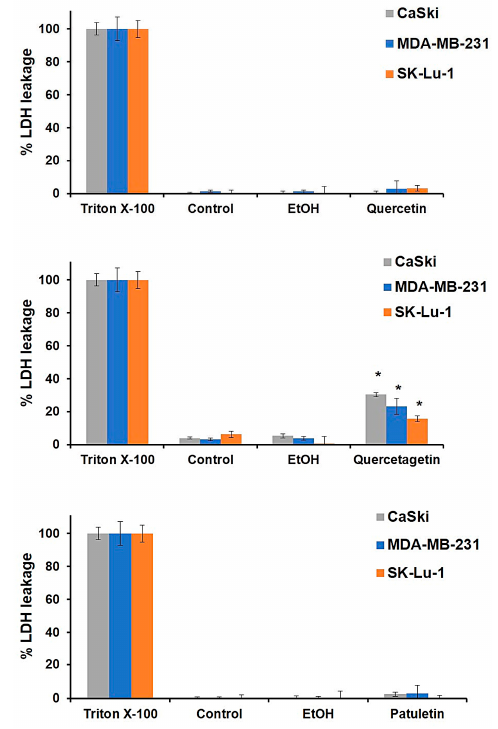
Figure 5. LDH activity induced by quercetin, quercetagetin and patuletin on CaSki, MDA-MB-231 and SK-Lu-1 cultures. In each case, 7500 cells/well were seeded in 96-well tissue culture plates. After 24 h, the medium was removed, and the cells were stimulated with the IC 50 values for quercetin, quercetagetin and patuletin, or EtOH (10 µ L/mL). The amount of lactate dehydrogenase (LDH) released into the culture supernatant was measured after 24 h of treatment. Experimental data are presented as mean ± S.D. for three independent experiments with three repetitions. * p < 0.05 versus EtOH (ANOVA followed by a Tukey’s